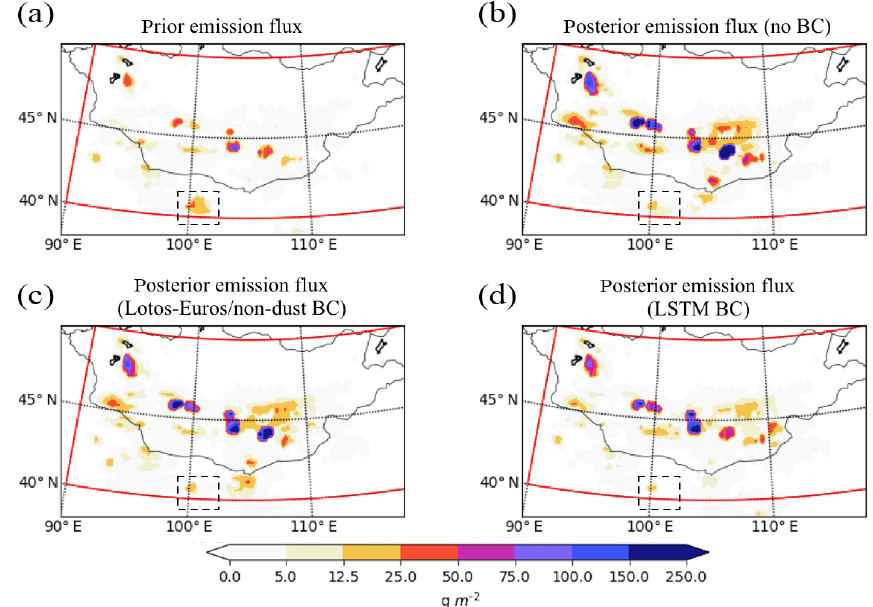
Figure 7. Accumulated dust emission map F between 14 April at 08:00 and 15 April at 19:00 of the a priori model (a) or (b) a posteri- ori estimates using the original PM 10 observations, (c) LOTOS-EUROS, or (d) LSTM-based bias-corrected dust measurements. BC: bias